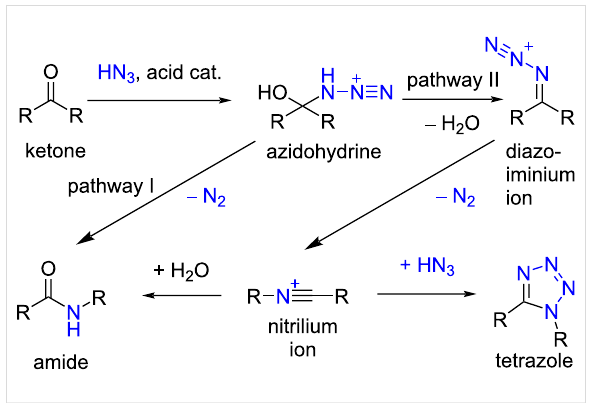
Figure 2: Mechanism of the Schmidt